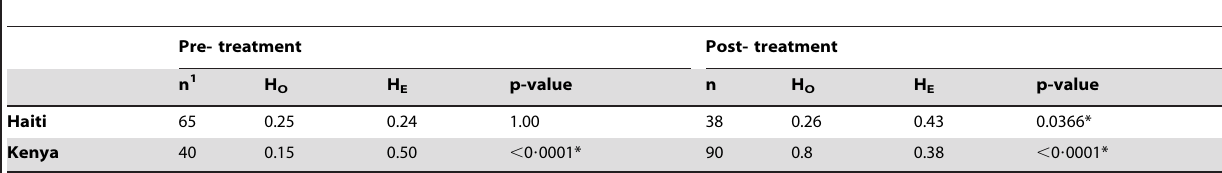
Table 3. Observed (H O ) and expected (H E ) heterozygosity tested under HWE for SNP 200 in T. trichiura .